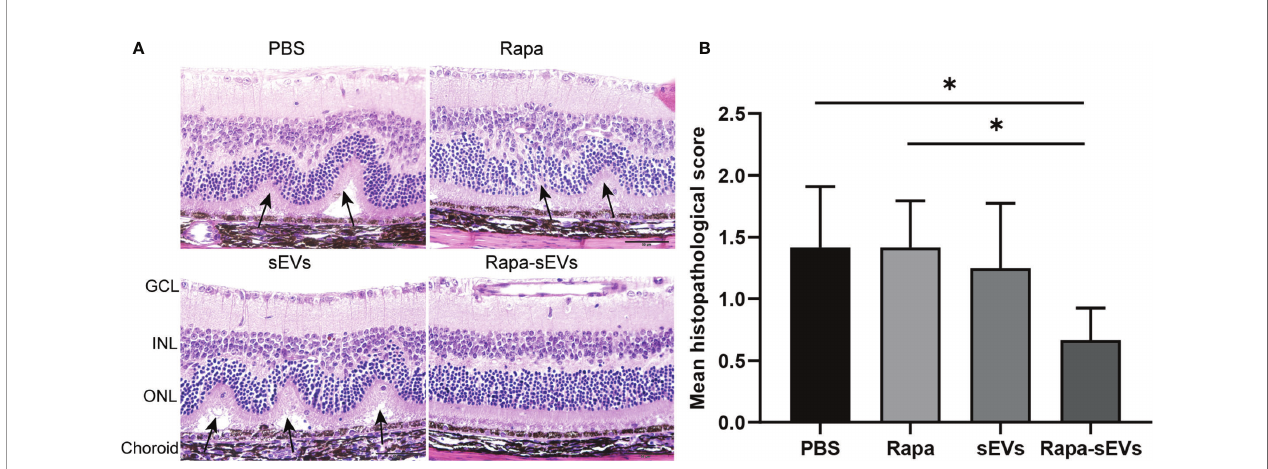
FIGURE 6 | Histological assessment of the retina in EAU. (A) Representative H&E staining images of PBS, Rapa, sEV, and Rapa-sEV treated groups. The black arrows represented the retinal folds and detachments near the optic disk. GCL, ganglion cell layer; INL, inner nuclear layer; ONL, outer nuclear layer. (B) Results are expressed quantitatively as histopathological scores. Values are expressed as the mean ± SD of six mice (6 eyes) per group. *P < 0.05, Kruskal-Wallis